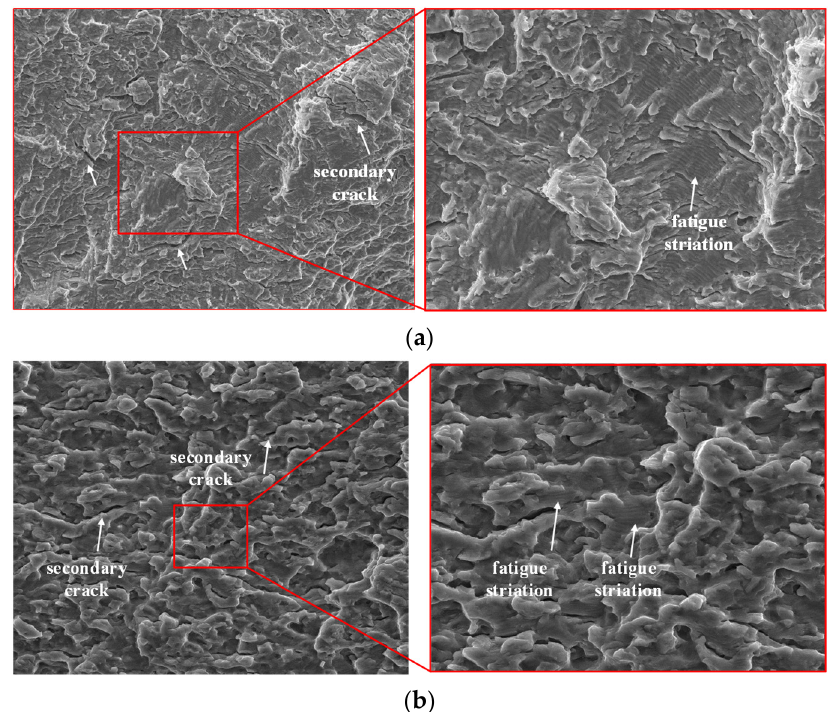
Figure 14. Fatigue crack propagation zone of the specimen. ( a ) Turned specimen; ( b ) Ultrasonic- impacted specimen.